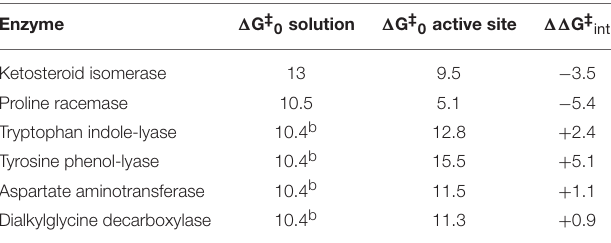
TABLE 2 | Marcus intrinsic barriers (kcal/mol) a .